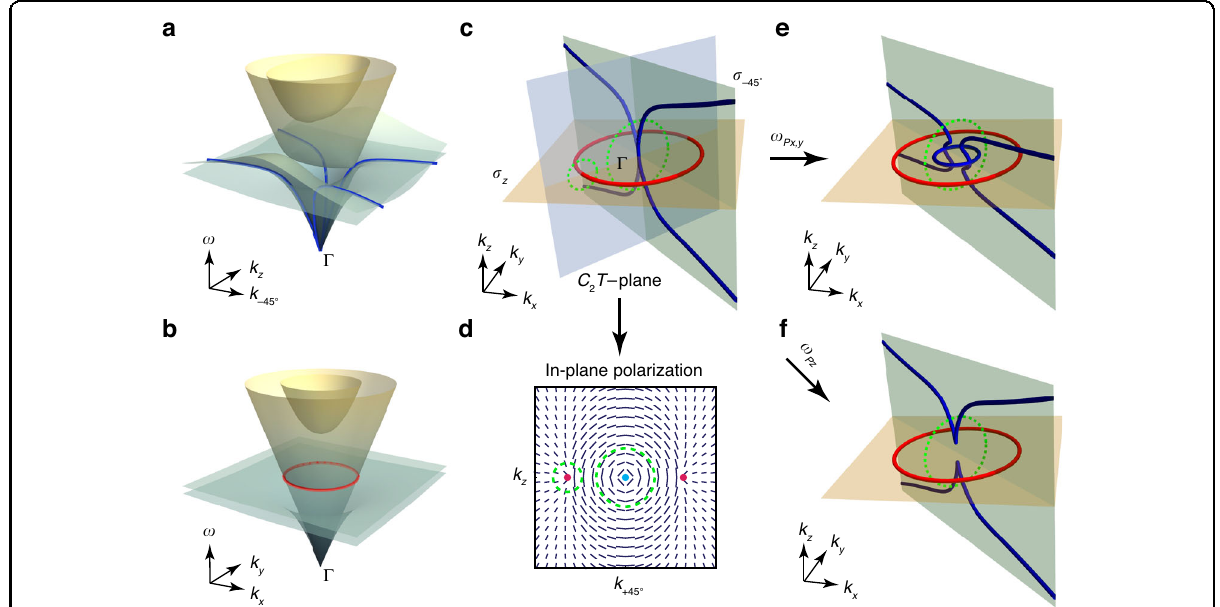
Fig. 2 In-plane nodal chain and nodal link in bi-anisotropic metamaterials. a Band structure of the bi-anisotropic effective medium model in the space of [ k − 45° , k z , ω ]. The blue lines are band degeneracies. Parameters adopted are ω 0 = 2, A = 0.5, l = L = 1. b Band structure with k z = 0, nodal ring is shown in red. c Nodal link in momentum space, in-plane nodal chain is shown in blue and the red circle is a nodal ring. Green circles indicate the π 1 homotopy loops in the C 2 T - invariant plane. d The projected polarization states of the 2nd band at the C 2 T - invariant plane, the red dots are cut- positions of the nodal ring, blue dot is the in-plane nodal chain point at the Γ point. Green circles indicate π 1 loops encircling different degeneracy nodes as in c . e The breaking of chain point with an in-plane plasmonic resonance, where a new nodal ring (blue) emerges on the k z = 0 plane. The nodal ring connects the two nodal line branches as a consequence of the − 1 non-Abelian charge accumulated along the green loop. f The breaking of chain point with z direction plasmon resonance. No new nodal structure shows up since the green loop still encircles two nodal lines and the − 1 charge remains